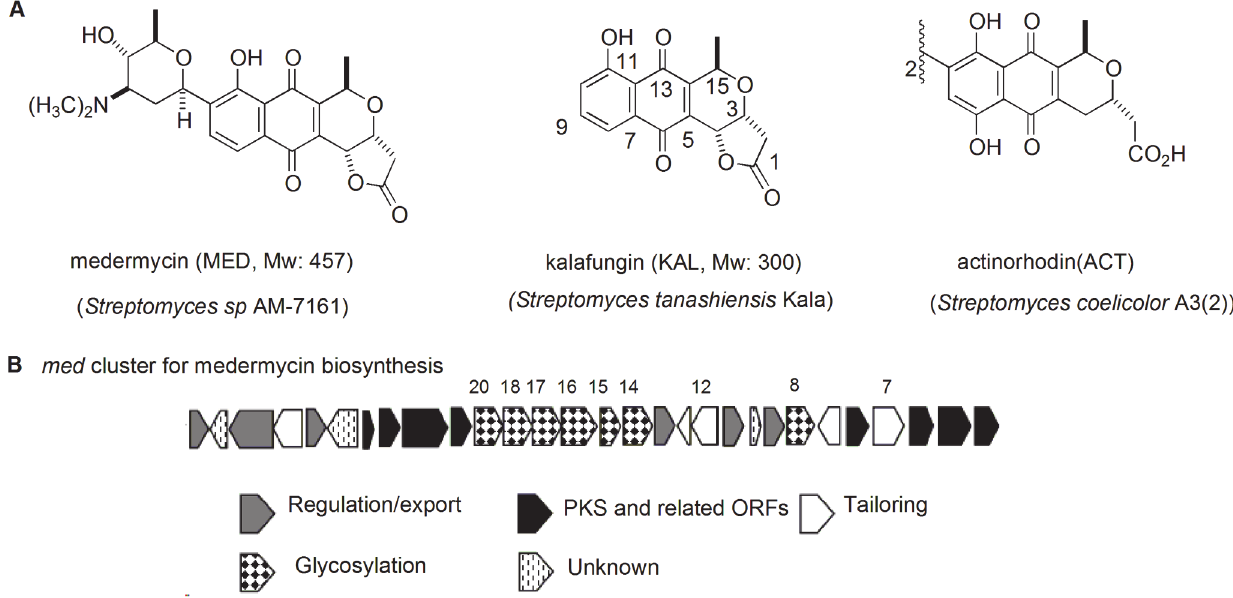
Fig 1. Structures of several important BIQ antibiotics and medermycin biosynthetic gene cluster. (A) Structures of three BIQ antibiotics and their producing strains. The numbering given is based on the biosynthetic origin of these compounds. (B) Organization of the gene cluster for